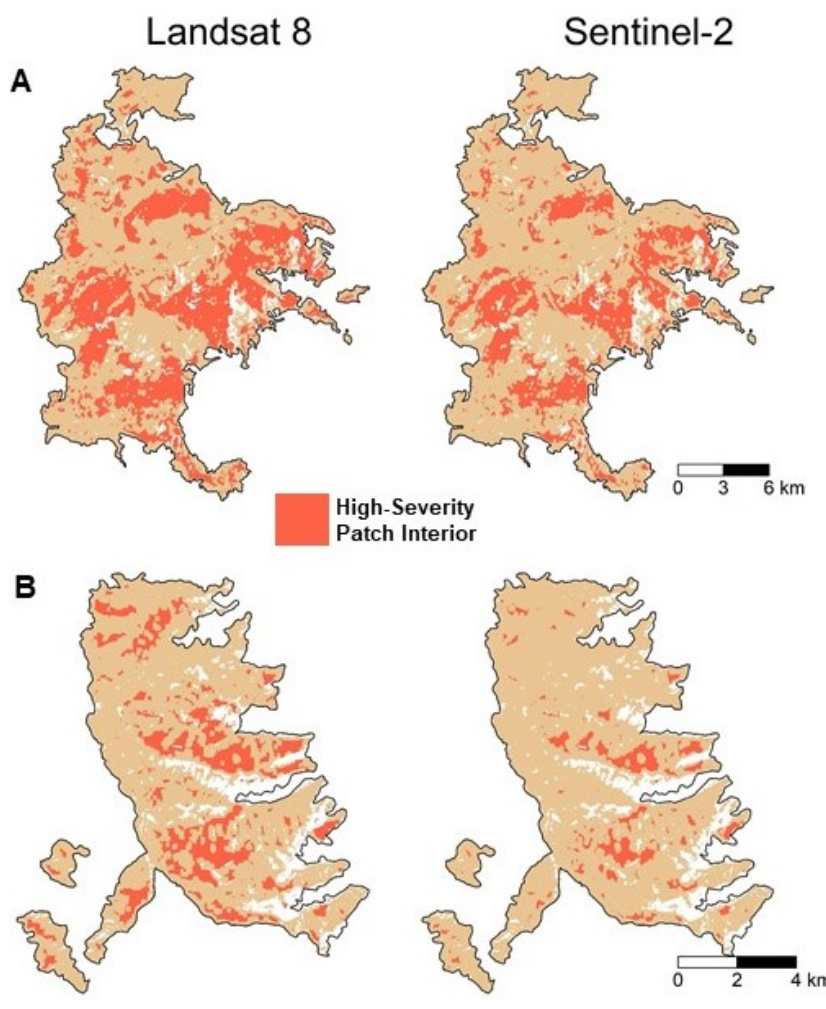
Figure 3. Maps of high-severity patch interior for the 2017 Meyers fire in southwestern Montana ( A ), and the 2018 Trail Mountain fire in central Utah ( B ) derived from Landsat (left column) and Sentinel (right column) imagery. High-severity patch interior (red) was mapped from all high-severity pixels 90 m or further from the nearest low- or moderate-severity forest-classified pixel. Tan areas represent all other forest-classified pixels; white areas were classified as non-forest. For the Meyers fire, Landsat predicts 10.7% more high-severity patch interior than Sentinel (2801 additional hectares). For the Trail Mountain fire, Landsat predicts 11.0% more high-severity patch interior than Sentinel (710 additional hectares). Maps using Landsat imagery are at their native 30 m resolution, while Sentinel maps use 10 m resolution. Severity was derived from RdNBR measured using the extended compositing approach in GEE, with severity thresholds estimated from NLS models of the satellite-derived burn severity fit to field-based CBI measurements.